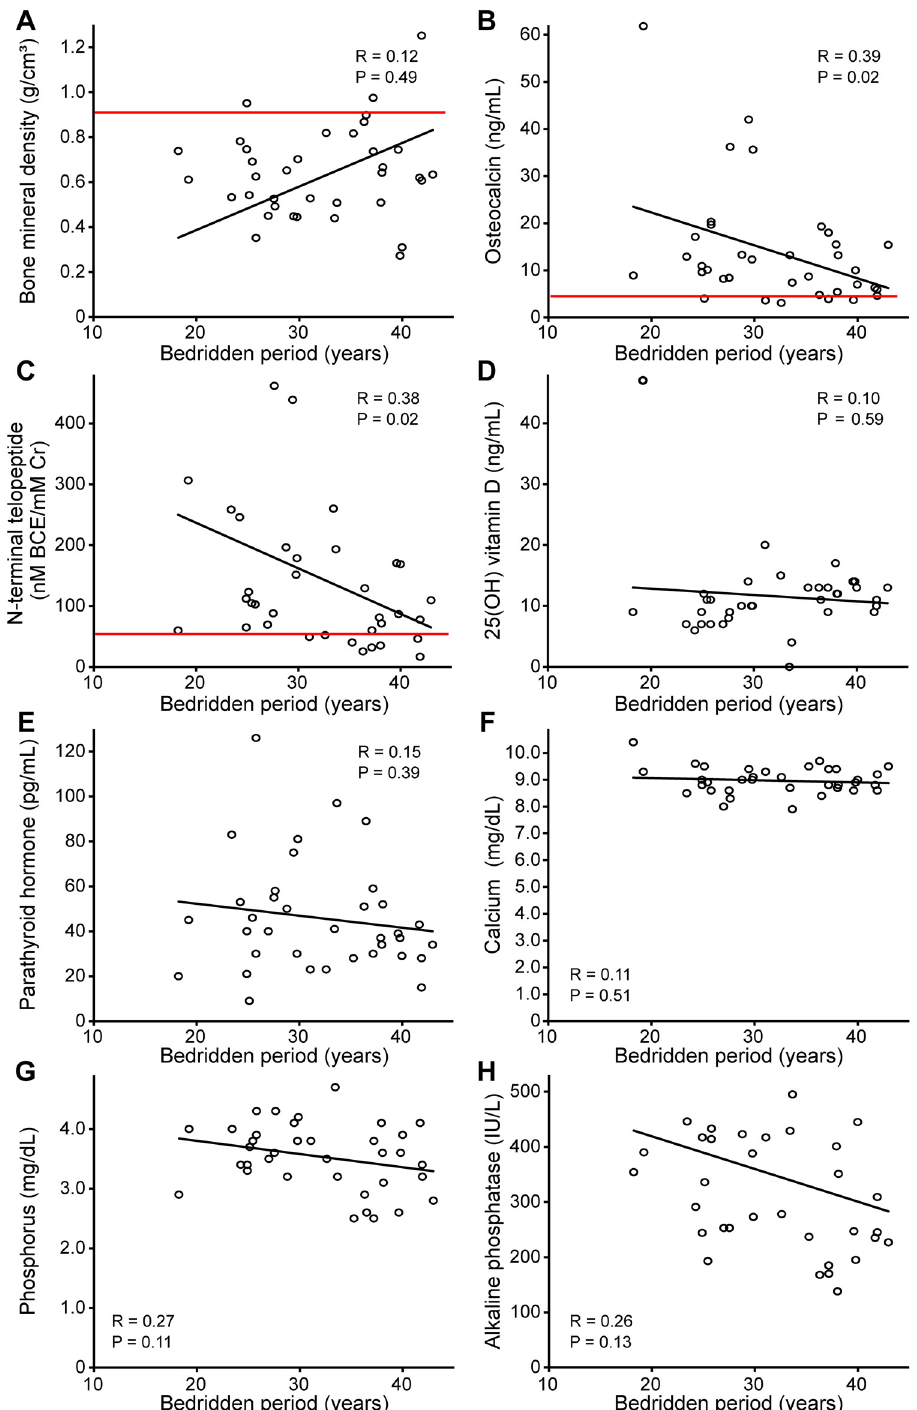
Fig 1. Bone mineral density and bone metabolism marker levels according to the period of bed confinement in all study patients. Because all patients had been bedridden from birth, the period of bed confinement was equal to their age. A) Correlation between the bone mineral density of lumbar spine vertebrae 2 – 4 in the anteroposterior projection and the period of bed confinement. Correlation between the bone metabolism marker levels, including the serum osteocalcin levels (B), urine N-terminal telopeptide levels (C), serum 25 (OH) vitamin D levels (D), serum intact parathyroid hormone levels (E), serum calcium